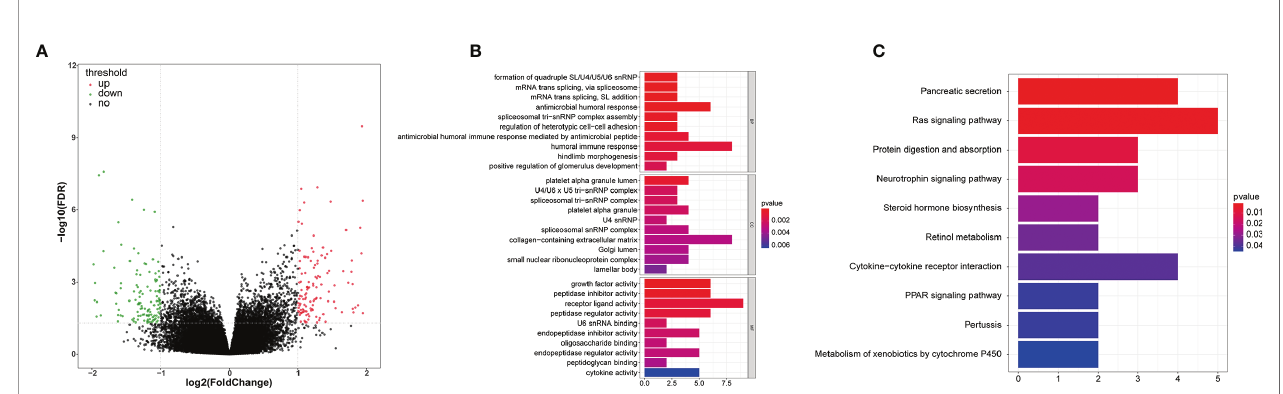
FIGURE 8 | The GO and KEGG function enrichment analyses of the DEGs between high- and low-risk groups in LCRC patients. (A) A volcano plot of DEGs in the high- and low-risk groups. Red indicates up-regulated genes, green indicates down-regulated genes (high-risk group versus low-risk group), and black indicates no signi fi cant difference. The Top 10 biological processes, cellular components, molecular functions (B) and KEGG pathways (C) were illustrated. The color of the bar demonstrates P-value. Therefore, blue bars have a more signi fi cant P-value than red ones.